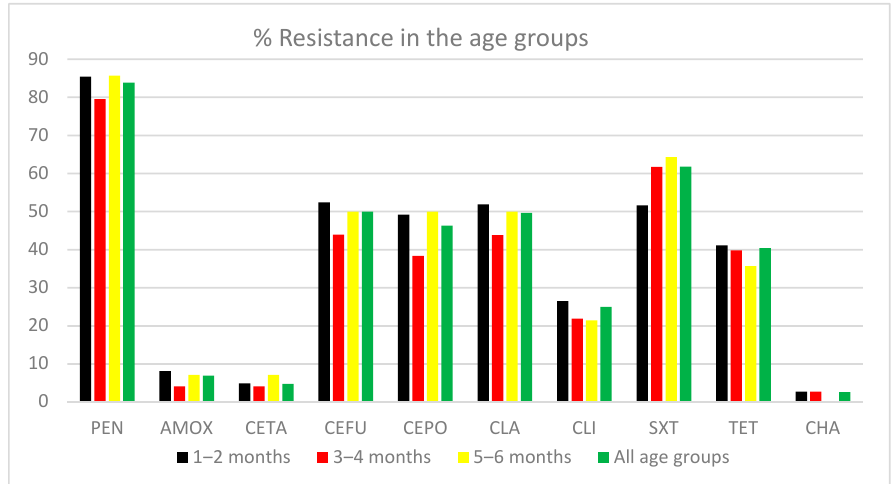
Figure 1. Antibiotic resistance rate in each age group. PEN (Penicillin); AMOX (Amoxicillin); CETA (Cefotaxime); CEFU (Cefuroxime); CEPO (Cefpodoxim); CLA (Clarithromycin); CLI (Clindamycin); SXT (Sulfamethoxazole-Trimethoprim); TET (Tetracycline); CHA (Chloramphenicol).